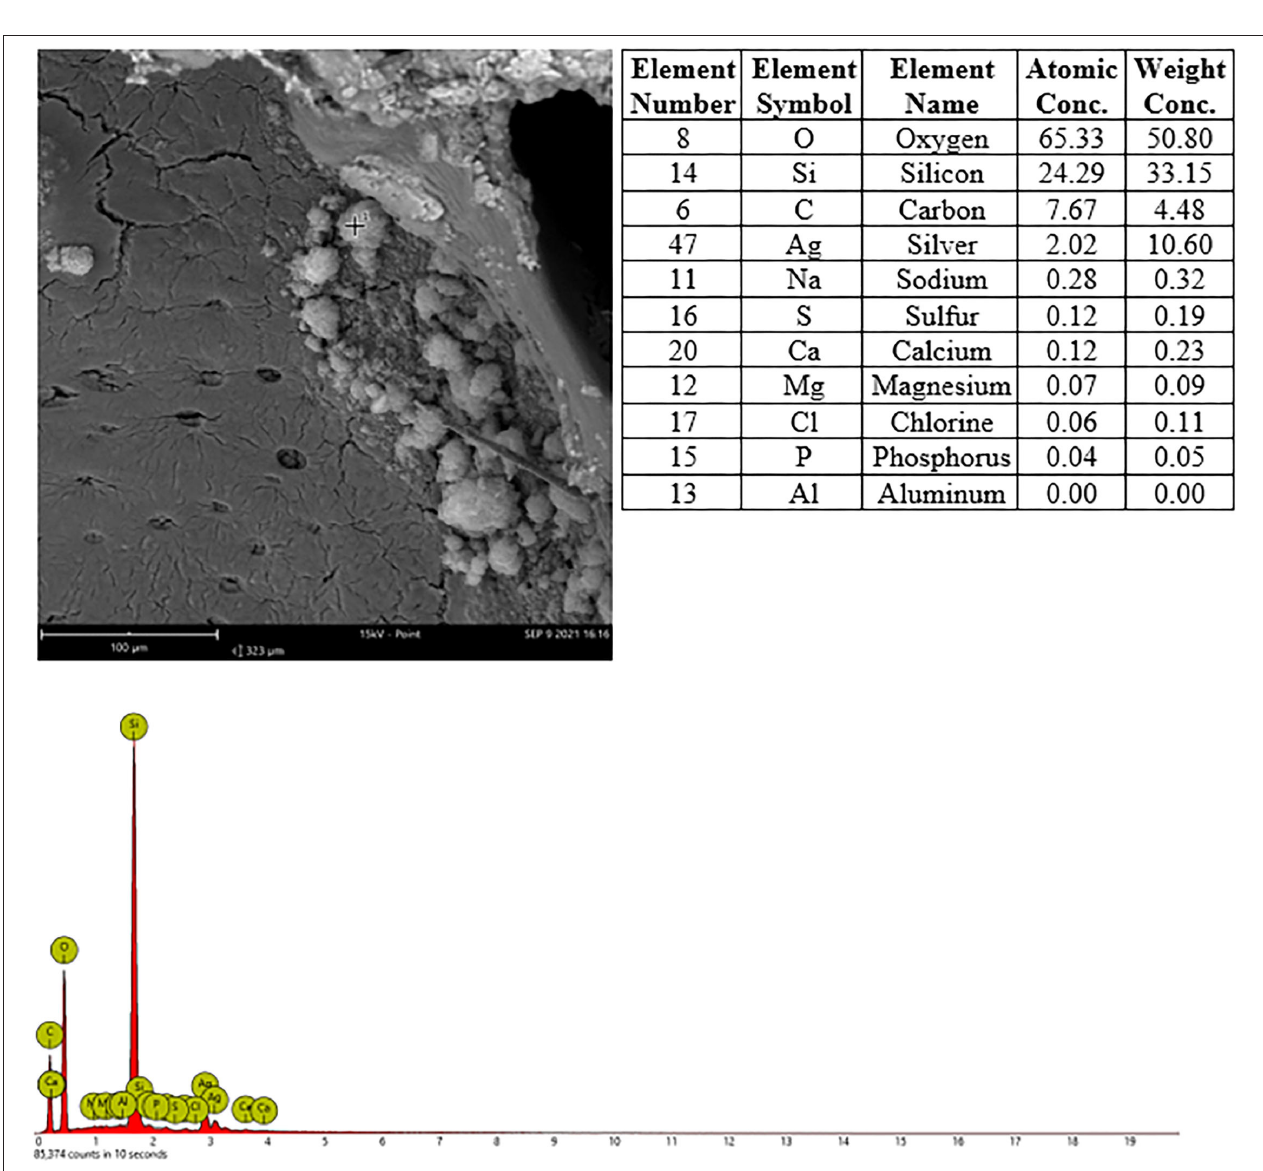
FIGURE 5 | Male rat. Deceased after 2 ¾ h after start of inhalation. Nasal cavity, frozen and dried, level 3, area 3, EDX point analysis showing SEM image, EDX spectrum, and atomic and weight concentration table of detected Si. Note: agglomeration of particles.